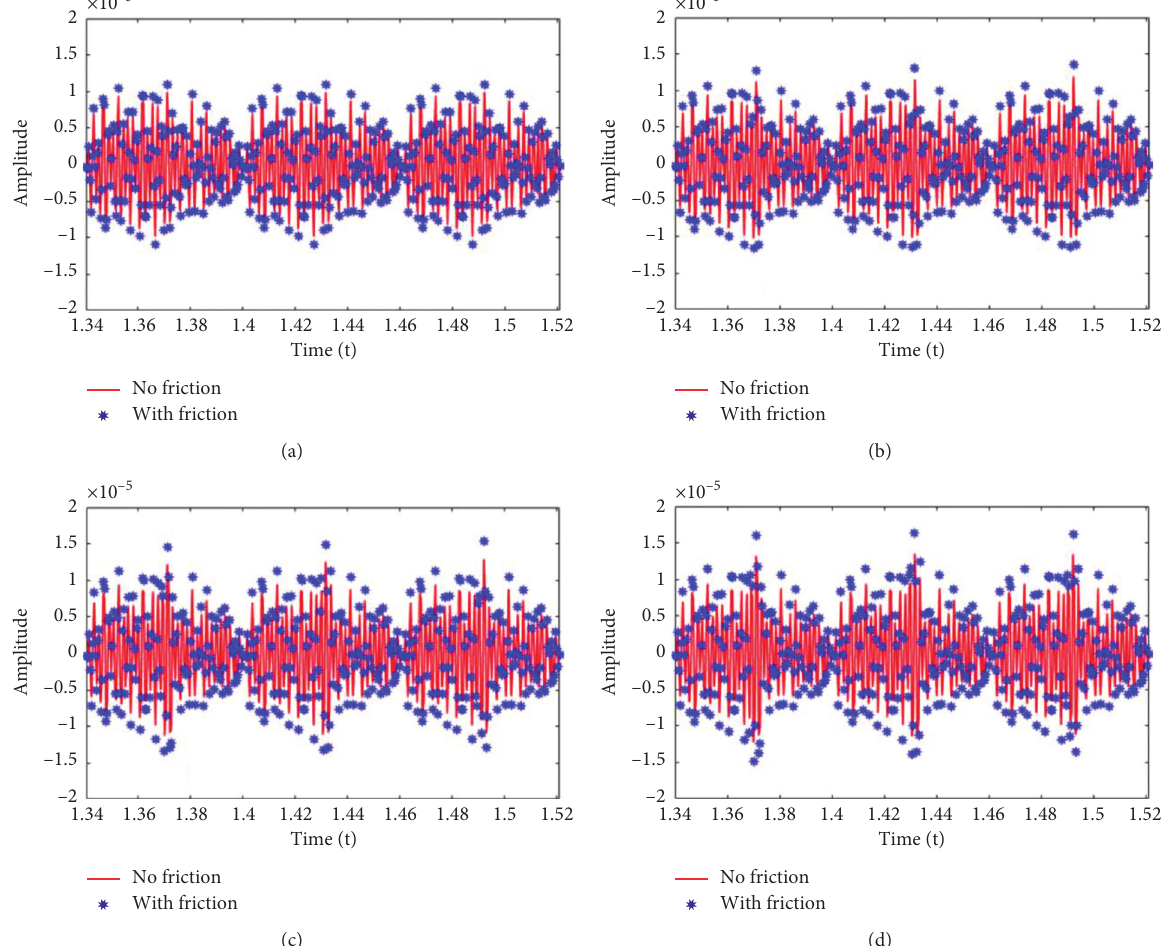
Figure 8: Time-domain response of torsional vibration of the transmission system. (a) Normal teeth. (b) 20%. (c) 30%. (d) 40%.